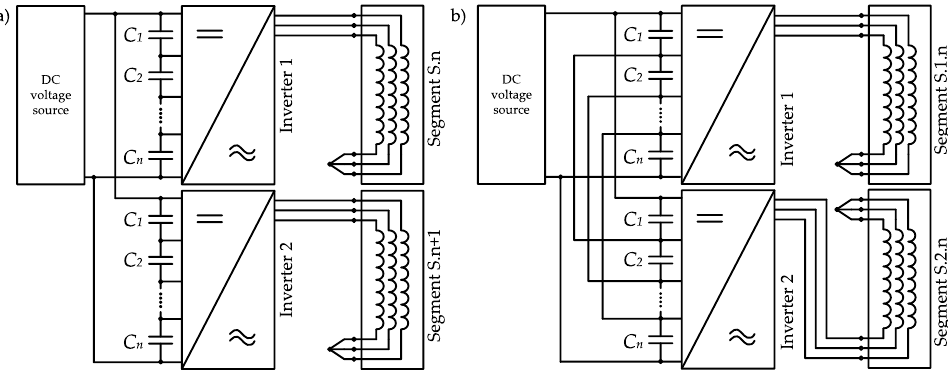
Figure 10. Multi-level inverters drive system: ( a ) typical topology, ( b ) newly proposed